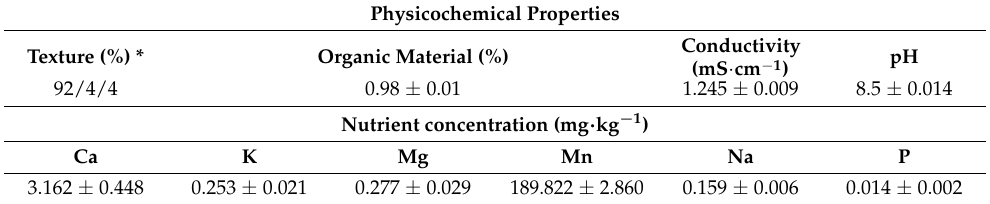
Table 1. Physicochemical properties and nutrient concentrations of soil from the Rio Piedras